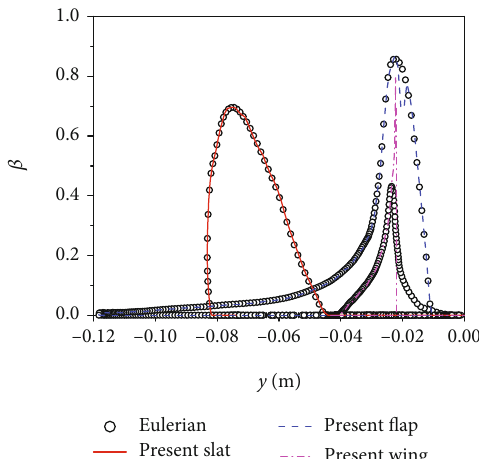
10: Comparison of collection e ffi ciency with the Eulerian result for the multielement airfoil at the droplet diameter of 20 μ